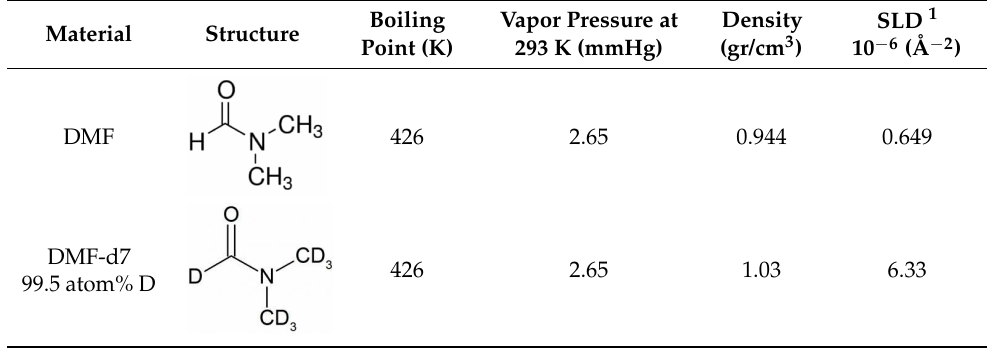
Table 1. Physical properties of the solvents DMF and deuterated